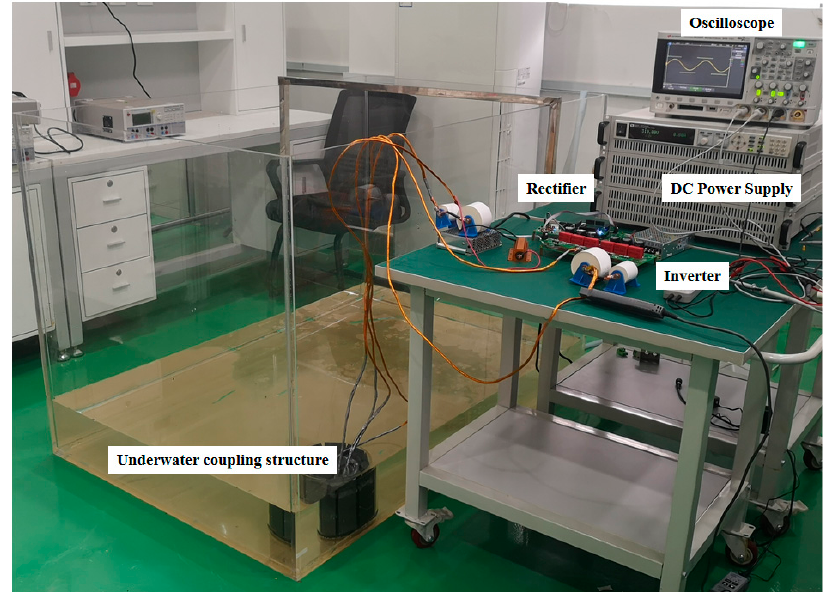
Figure 10. Proposed coupler structure: ( a ) basic structure; ( b ) prototype.